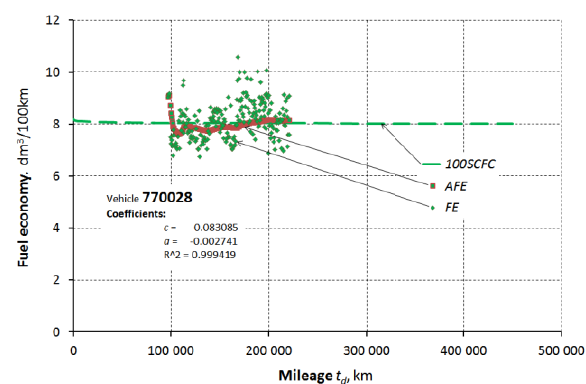
Fig. 4. Fuel economy of vehicle 770028